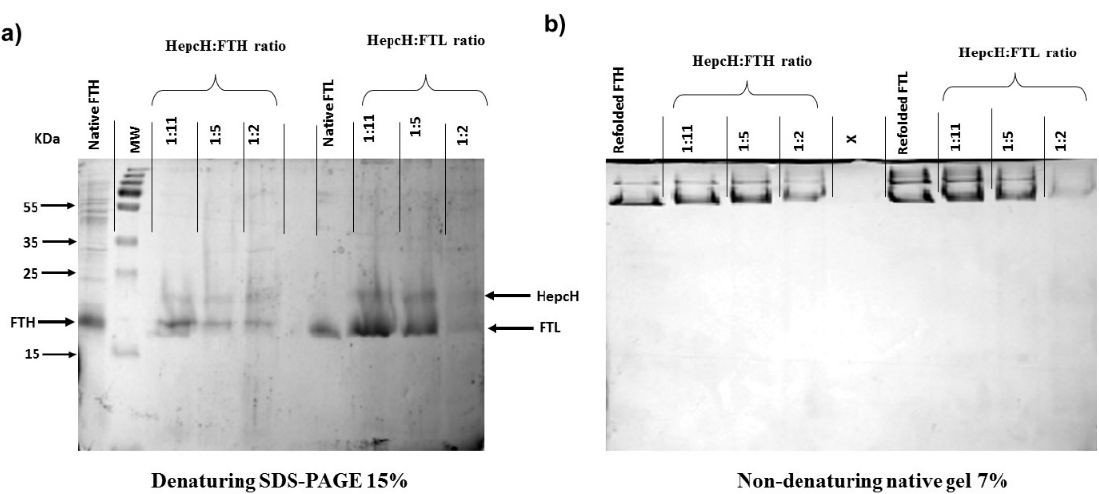
Figure 3. Assembly of HepcD-FTH and -FTL heteropolymers. ( a ) Denaturing SDS-PAGE analysis of the assembled HepcH-FTH and -FTL heteropolymers obtained after mixing different HepcH: FTH/FTL molar ratios (1:11; 1:5; 1:2). ( b ) Non-denaturing PAGE analysis of the assembled HepcH- FTH and -FTL heteropolymers at different ratios (1:11; 1:5; 1:2). Ratio HepcH:FTH or FTL = 1:1, corresponds to average number of 12 HepcH per 24 subunits. Ratio HepcH:FTH or FTL = 1:2, corresponds to average number of 8 HepcH per 24 subunits. Ratio HepcH:FTH or FTL = 1:5, corresponds to average number of 4 HepcH per 24 subunits. Ratio HepcH/FTH or FTL = 1:11, corresponds to average number of 2 HepcH per 24 subunits.